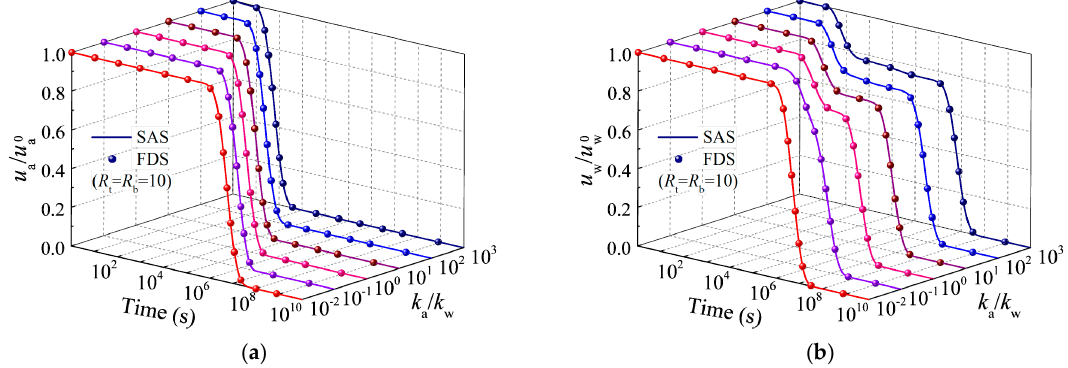
Figure 4. Excess pore-pressures under impeded drainage boundary calculated from semi-analytical solution (SAS) and finite difference solution (FDS): ( a ) air phase and ( b ) water phase.